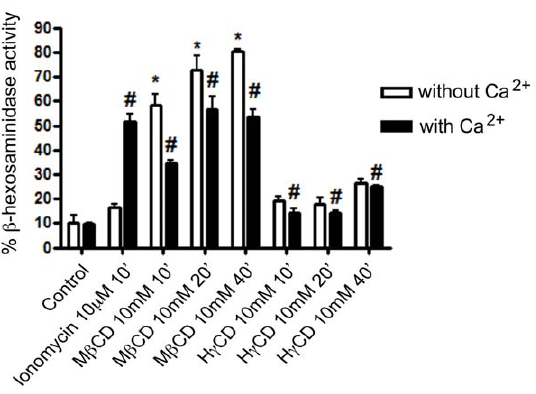
Figure 5. Lysosomal exocytosis events after cholesterol depletion are not due to cell death. After treatment with M b CD or H c CD, in the absence (white bars) or presence (black bars) of calcium, cardiomyocytes were trypsinized, collected and incubated with HFS solution, containing propidium iodide (PI). Cells that became inviable after drug treatment acquired PI labeling in their nuclei due to membrane permeability, and were counted as dead cells by flow cytometer. Data are shown as mean of triplicates 6